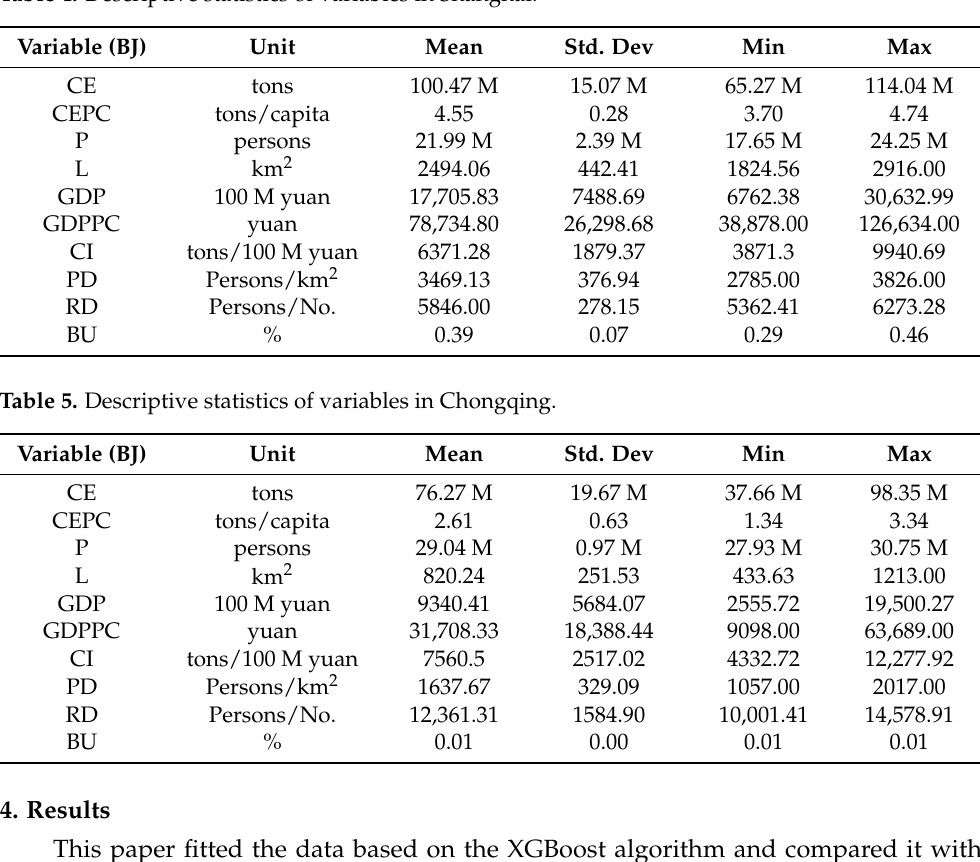
Table 4. Descriptive statistics of variables in Shanghai.